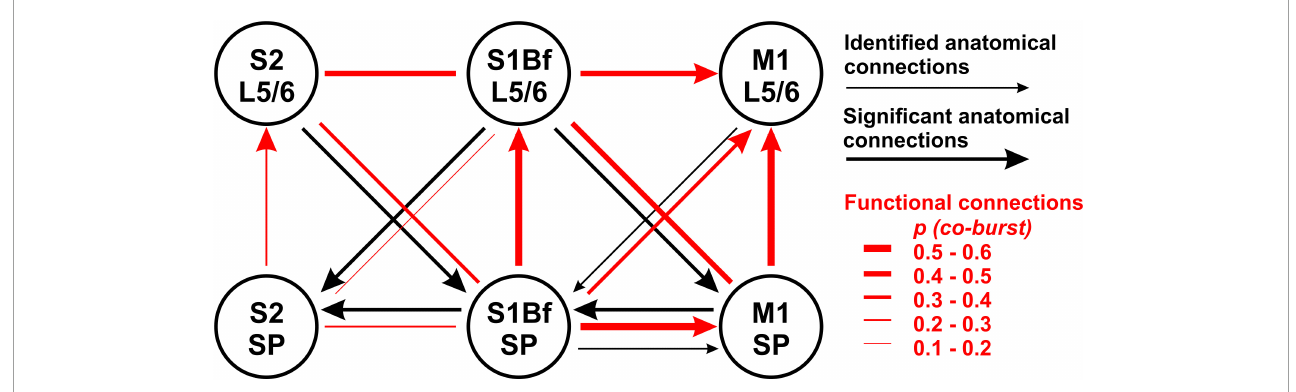
FIGURE7 Summary diagram for comparison of anatomical projections and functional connectivity between M1, S1Bf, and S2. Black arrows indicate the direction of backlabeled cell axonal projections toward the SP. Thick black arrows indicate if backlabeled cell number was significantly higher than expected. The red lines depict the estimated connectivity between two regions, as determined by the burst correlation. Arrowheads indicate a significant direction of burst correlation, as determined from burst initiation latencies. Note the clear direction in the functional connectivity from SP to L5/6 in all investigated regions and from S1Bf to